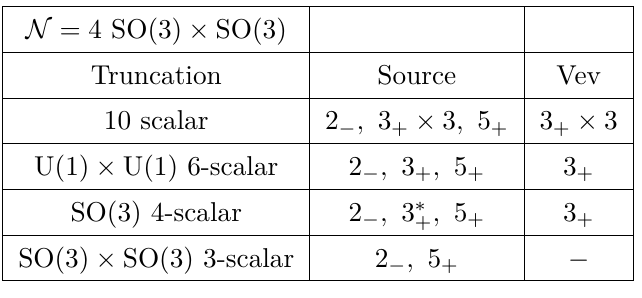
Table 3 . BPS modes and multiplicities for the N = 4 SO(3) × SO(3) invariant